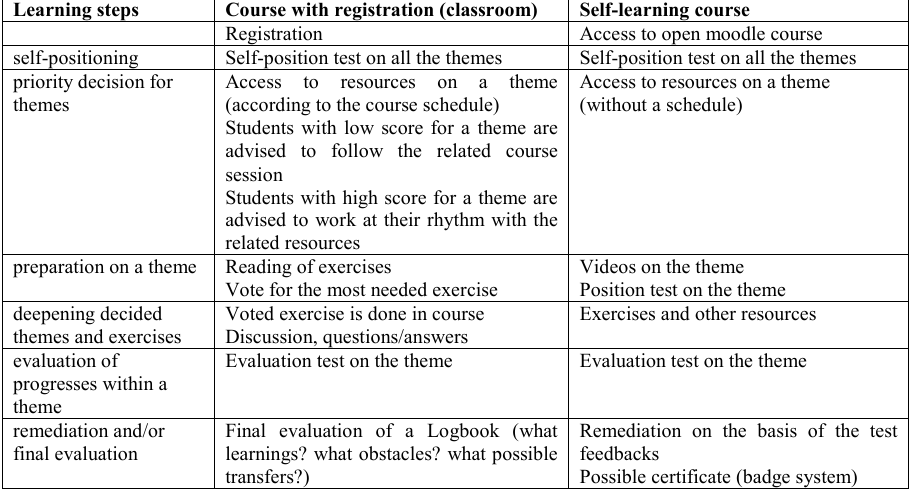
Table 2: Differences between the courses’